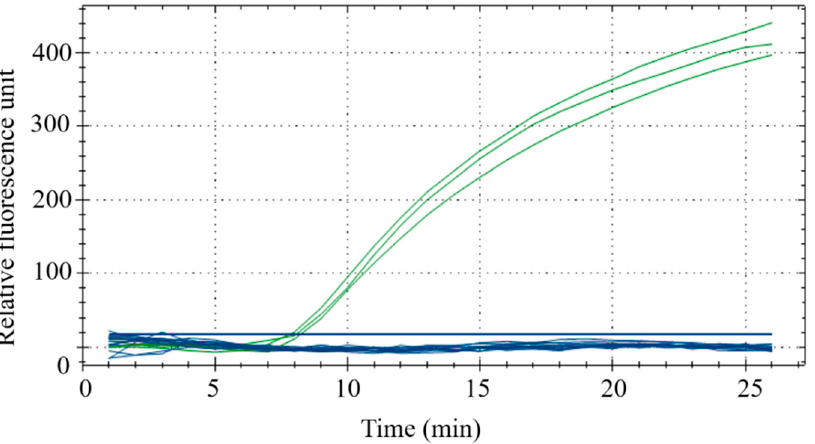
Figure 6. Interspecies specificity experiments. The samples for the green curve are duck meat and samples for the blue samples are beef, mutton, chicken, pork, fox meat, mouse meat, horse meat, venison, dog meat, pigeon meat, quail meat and goose meat.